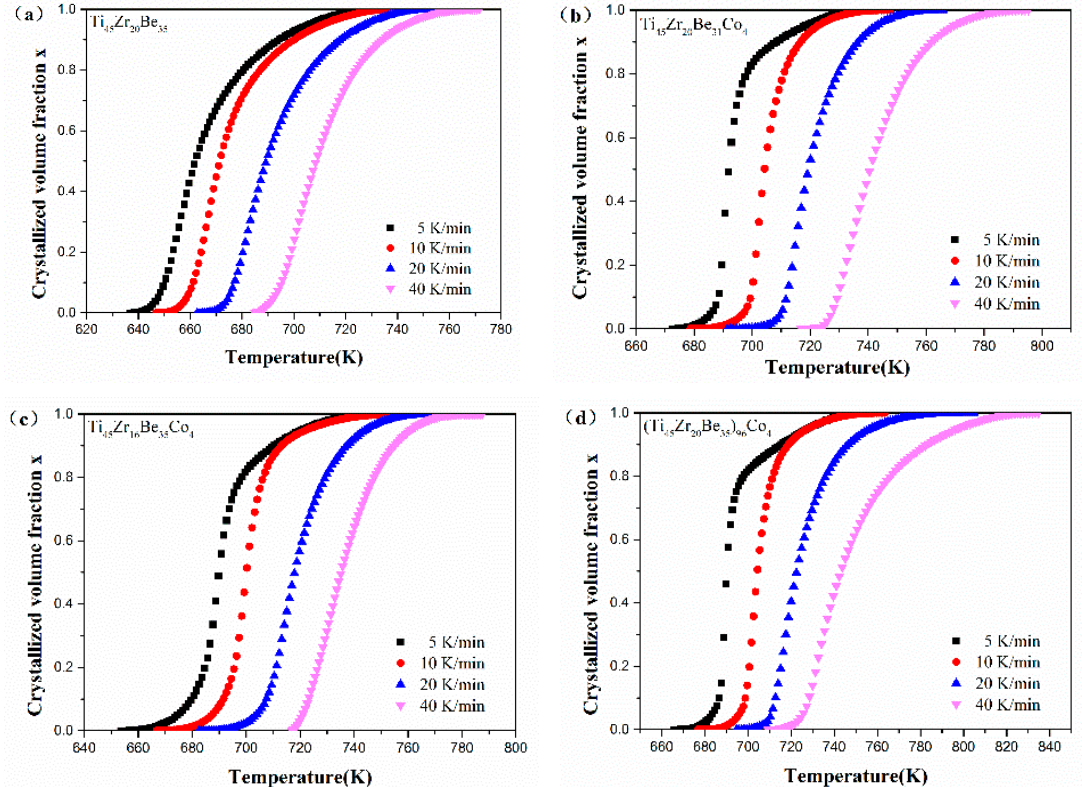
Figure 12. The crystallization volume fraction x as a function of temperature for ( a ) Ti 45 Zr 20 Be 35 , ( b ) Ti 45 Zr 20 Be 31 Co 4 , ( c ) Ti 45 Zr 16 Be 35 Co 4 , and ( d ) (Ti 45 Zr 20 Be 35 ) 96 Co 4 BMGs.